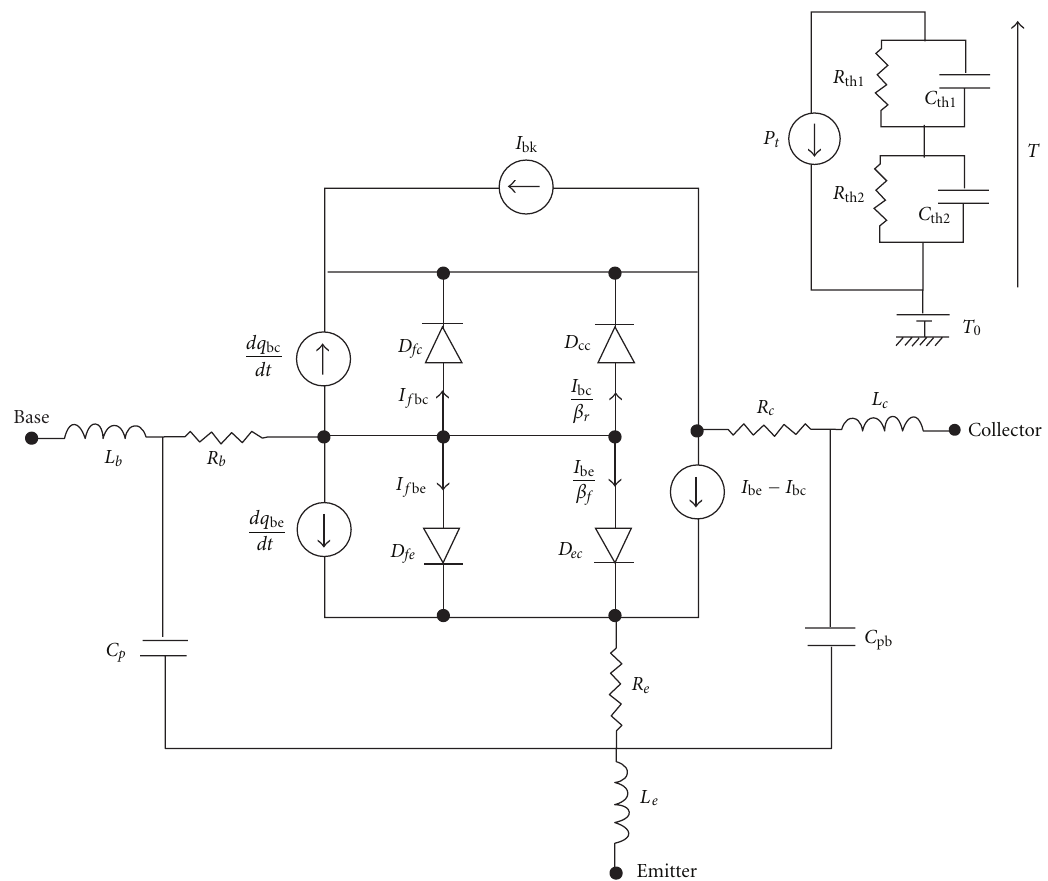
Figure 1: DHBT model π -topology with a two-pole RC thermal